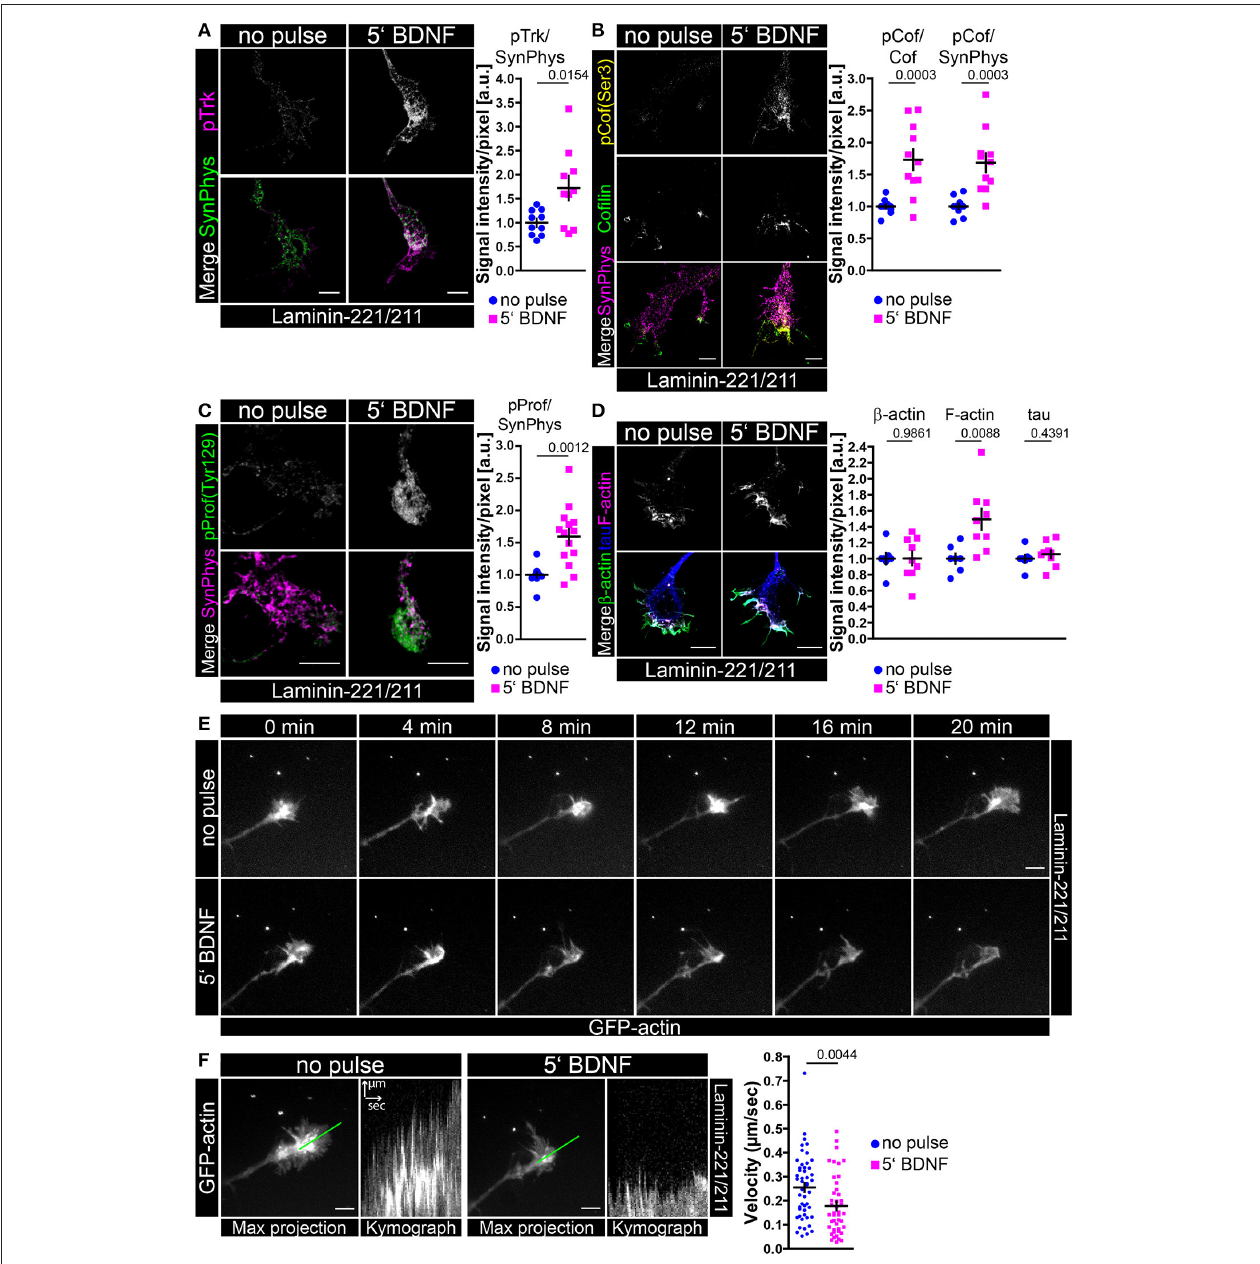
FIGURE 7 | Transient BDNF application on laminin-221 activates trkB signaling pathways in growth cones of motor axons resulting in phosphorylation of cofilin and profilin stabilizing actin. (A) Representative images of axonal growth cones of embryonic motoneurons cultured on laminin-221/211 for 5 days in vitro and stained against phospho-trk (magenta) and synaptophysin (green) (scale bar: 5 µ m). Upon BDNF pulse phospho-trk immunoreactivity was significantly increased (no pulse 1.00 ± 0.08, Q 2 1.00, n = 10, N = 136; 5 ′ BDNF 1.72 ± 0.25, Q 2 1.63, n = 10, N = 137; p = 0.0154), whereas synaptophysin levels were comparable. (B) BDNF stimulation also increased phospho-cofilin (Ser 3, yellow) intensities (pCof/cofilin–no pulse 1.00 ± 0.03, Q 2 1.00, n = 11, N = 174; 5 ′ BDNF 1.73 ± 0.17, Q 2 1.69, n = 11, N = 176; p = 0.0003), but did alter neither cofilin (green) nor synaptophysin (magenta) (scale bar: 5 µ m). (C) Representative images of axonal growth cones stained against phospho-profilin (Tyr 129, green) and synaptophysin (magenta) (scale bar: 5 µ m). Upon BDNF treatment the levels of phospho-profilin normalized to synaptophysin were enhanced (no pulse 1.00 ± 0.04, Q 2 1.00, IQR 0.09, n = 13, N = 200; 5 ′ BDNF 1.59 ± 0.12, Q 2 1.67, IQR 0.57, N = 14, n = 226; p = 0.0012). (D) In BDNF-pulsed growth cones F-actin (magenta) was significantly increased (1.49 ± 0.13, Q 2 1.48, n = 9, N = 236; p = 0.0088) in comparison to non-pulsed controls (1.00 ± 0.06, Q 2 1.00, n = 7, N = 194), whereas total β -actin (green) and tau (blue) appeared not changed (scale bar: 5 µ m). (E) Live-cell imaging of axonal growth cones of embryonic motoneurons cultured for 5 or 6 days in vitro and transduced with lentiviral constructs expressing actin-GFP. Time-lapse series of the same growth cone prior to and after BDNF pulse (scale bar: 5 µ m). Upon BDNF application filopodia dynamics appeared reduced indicating actin stabilization. (F) Filopodia dynamics were assessed as multiple kymographs revealing significantly reduced actin movement upon BDNF pulse (no pulse 0.25 ± 0.02 µ m/s, Q 2 0.27 µ m/s, IQR 0.20 µ m/s, N = 49; 5 ′ BDNF 0.18 ± 0.02 µ m/s, Q 2 0.14 µ m/s IQR 0.16 µ m/s, N = 44; p =